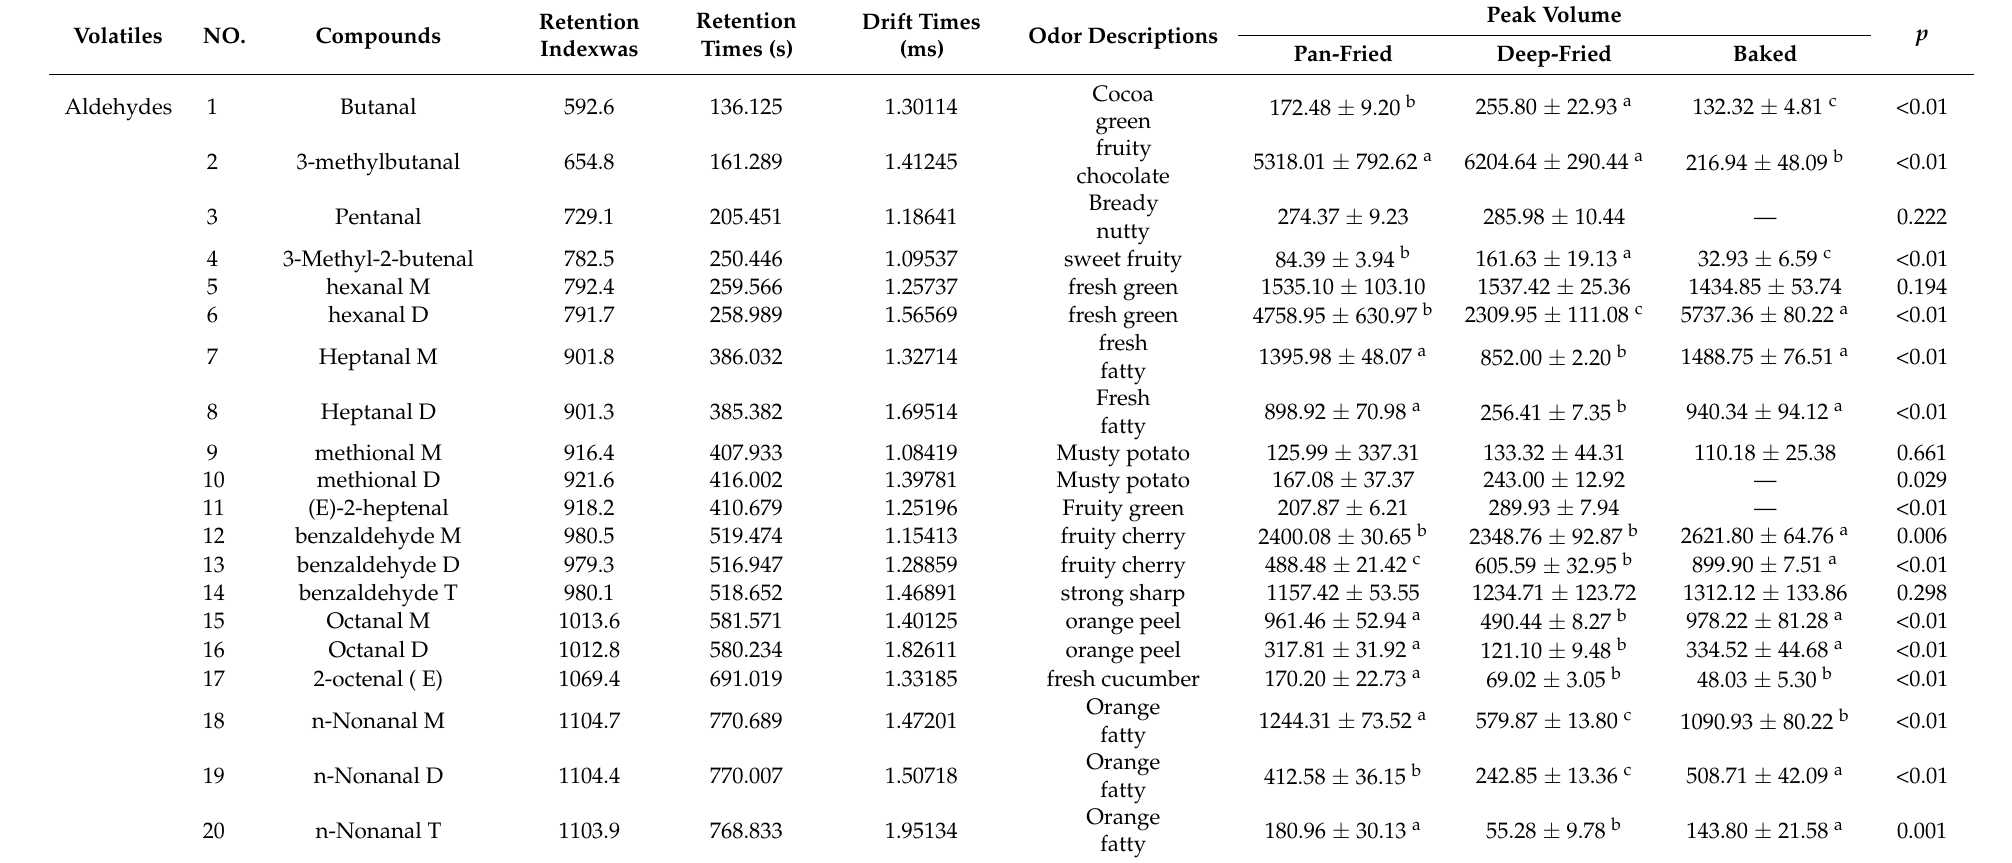
Table 6. Influence of different processing methods on the flavor substances of BTS